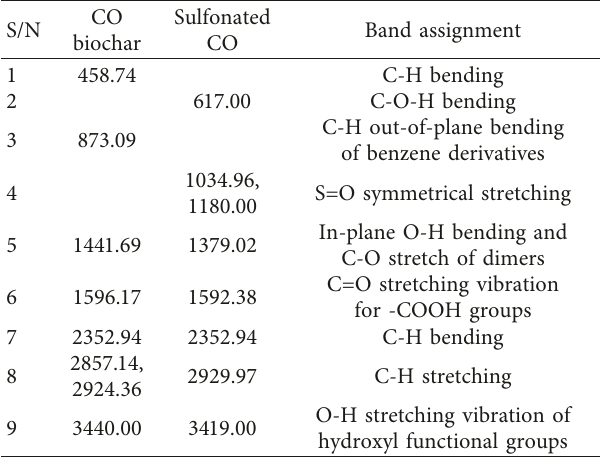
Table 3: Analysis of FT-IR spectra of the raw and activated biochar from C. odorata . S/N biochar